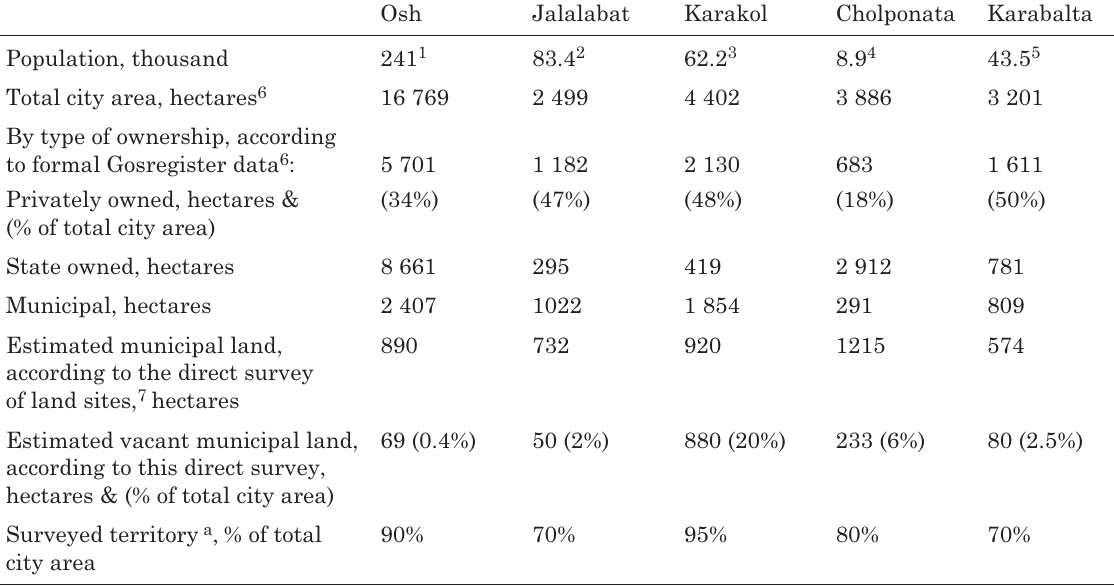
Table 2. Population and land of fi ve